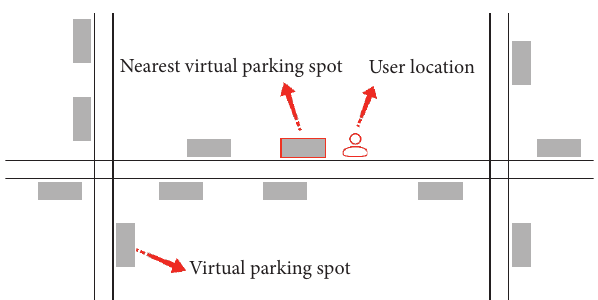
Figure 1: An illustration of the distribution of virtual parking spots. Users can easily query the surrounding and the nearest virtual parking spots through the EBSS